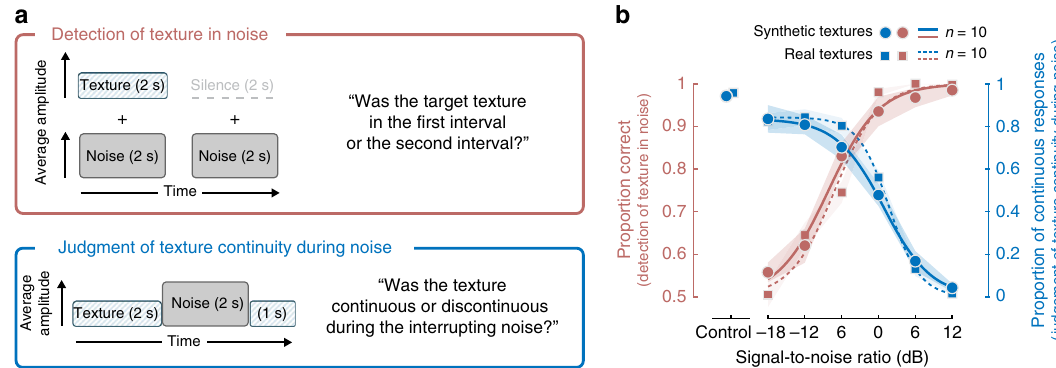
Fig. 5 Experiments 4a and 4b — relation of masking to illusory texture. a Top: Detection of texture in noise (red; Experiment 4a). The stimulus consisted of two Gaussian noise signals that were 2 seconds in duration, separated by a 400 ms inter-stimulus interval. One of the signals had a texture excerpt superimposed on the noise. Listeners identi fi ed the stimulus interval that contained the texture. Bottom: Judgment of texture continuity during noise (blue; Experiment 4b). Stimulus construction and task were identical to that of Experiment 1. The stimulus consisted of a 2 s excerpt of a texture, immediately followed by 2 s of noise, immediately followed by another 1 s of the texture. We ran two versions of each experiment: one with real-world texture recordings, and one with synthetic textures generated from statistics measured from real-world recordings. Listeners judged whether the inducer texture was continuous or discontinuous during the interrupting noise segment. The SNR was varied across the same range in the two experiments. b Results of Experiments 4a and 4b. In Experiment 4a (red), the detectability of the target texture in noise decreased with SNR. In Experiment 4b (blue), listeners more readily reported the texture as continuous with decreasing SNR. The two lines correspond to the two versions of the experiments (circles and solid lines: synthetic textures; squares and dashed lines: real-world texture recordings). Control conditions featured stimuli where the inducer was higher in level and physically present during the interrupting noise (same as one of the control conditions in Experiment 1; see Fig. 2b, left panel). Shaded regions show SEM